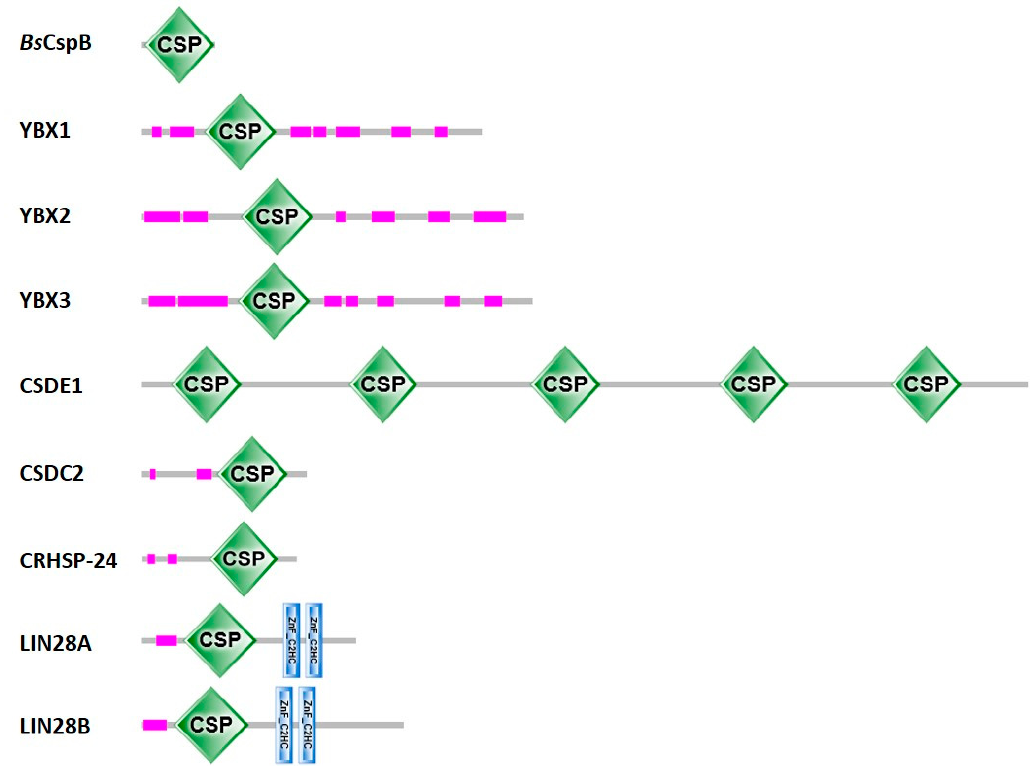
Figure 2. Proteins with cold-shock domains. Domain annotations for one representative bacterial CSP and human CSD- containing proteins according to SMART [27]. For CSDE1, Pfam [31] agrees with the domain annotation shown here. Uniprot [22] annotates two additional CSDs in CSDE1, one between CSD3 and CSD4 and one between CSD4 and CSD5, as well as two additional truncated CSDs, one between CSD1 and CSD2 and one between CSD2 and CSD3. InterPro [32] annotates a total of nine CSDs in CSDE1, those shown here and four additional CSDs filling the gaps. CSDs are displayed as green diamonds labeled “CSP”, the stunted CCHC-type zinc fingers (zinc knuckles) present in the LIN28 proteins as blue vertical bars, and low-complexity sequences as pink bars. Proteins are drawn to scale.